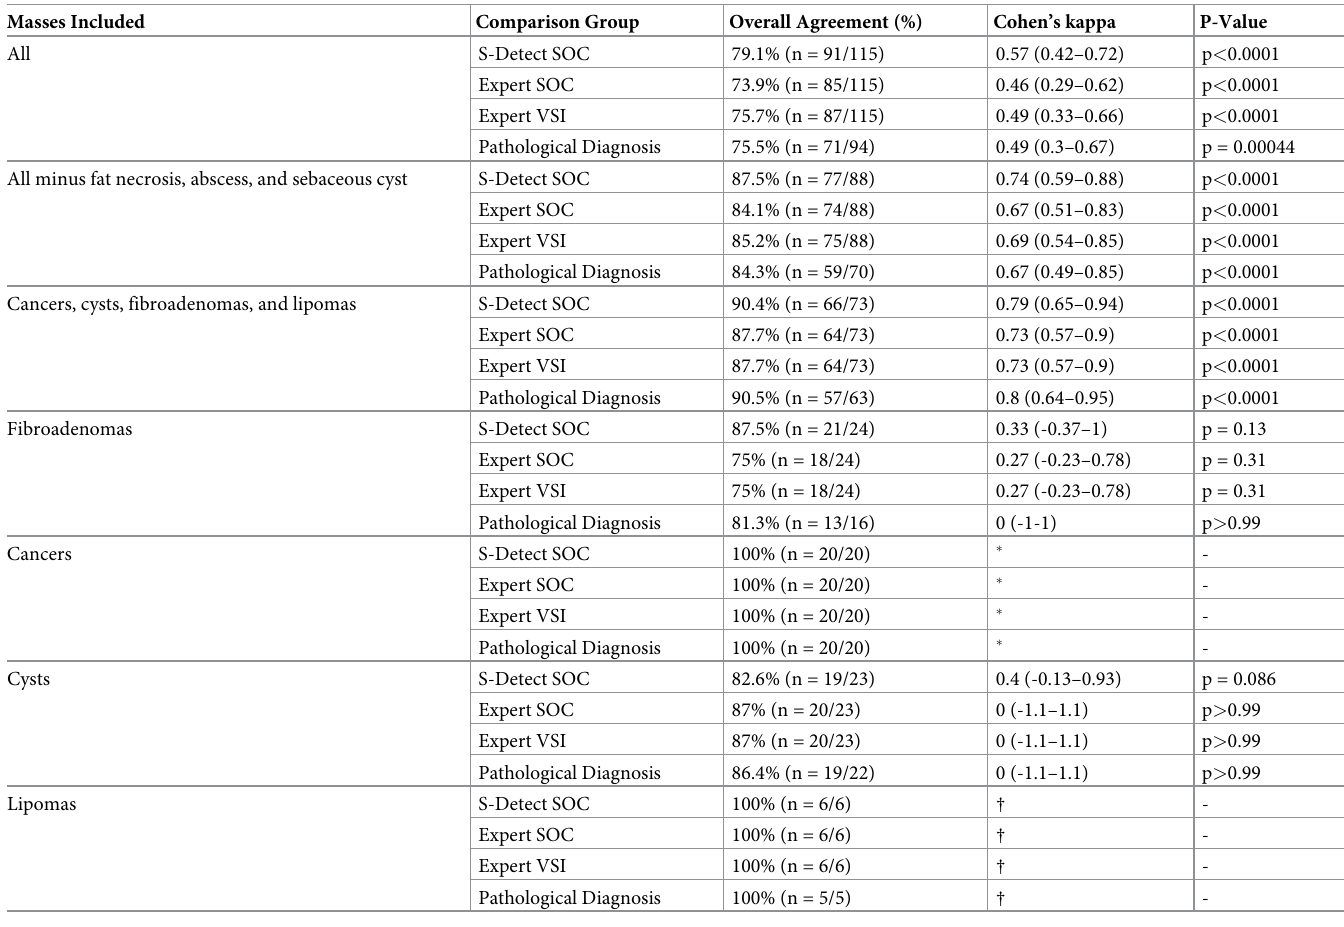
Table 2. Agreement between S-Detect interpretation of malignancy on VSI, compared to other interpretations, sub-divided by the masses included in the analysis. SOC = standard of care. Masses